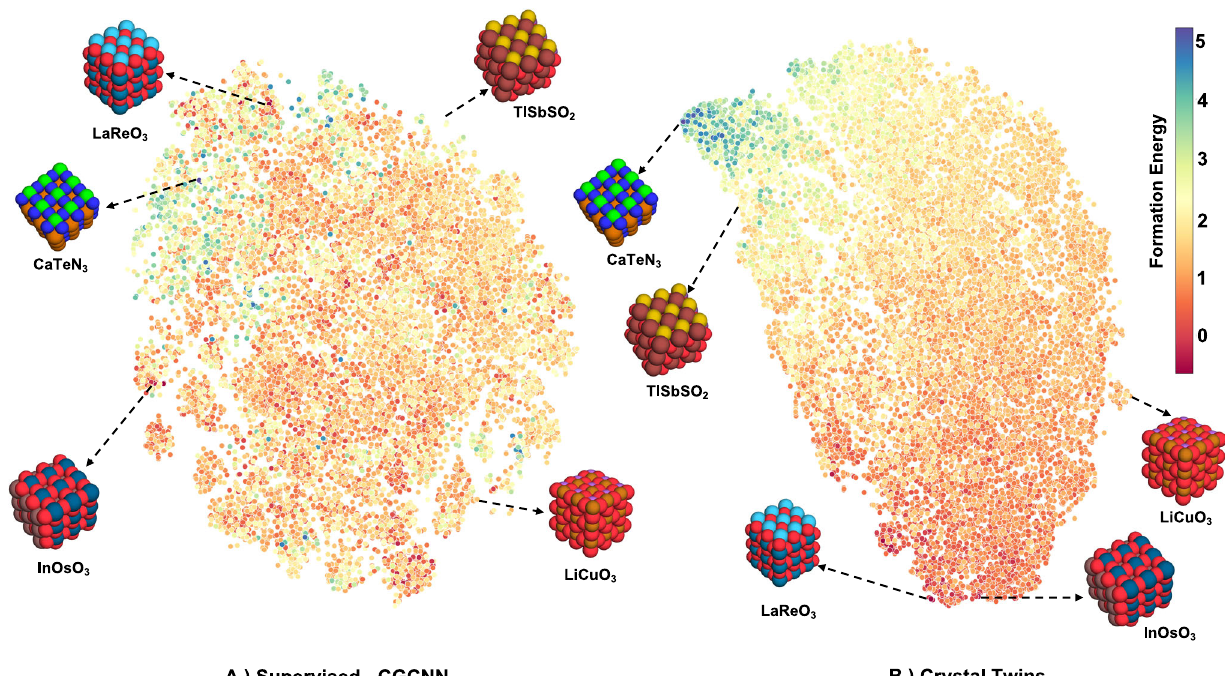
Fig. 3 Visualizing the embeddings space for the perovskites dataset using t-SNE. Every point on the t-SNE plot is colored corresponding to the formation energy of the crystalline system. ( A ) The t-SNE plot for the embedding was generated from the CGCNN model. ( B ) The t-SNE plot for the embedding was generated from the graph encoder of CT model after fi